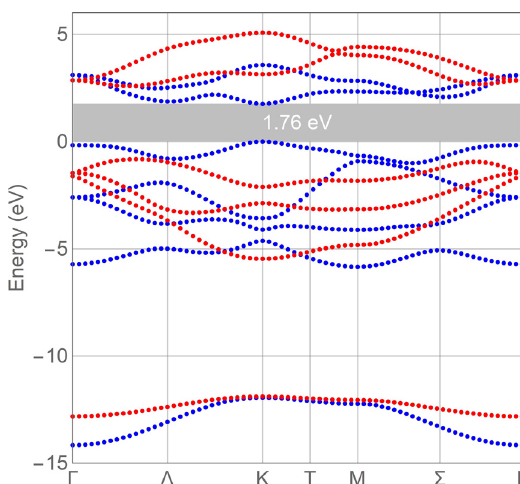
as given by the DFT 2